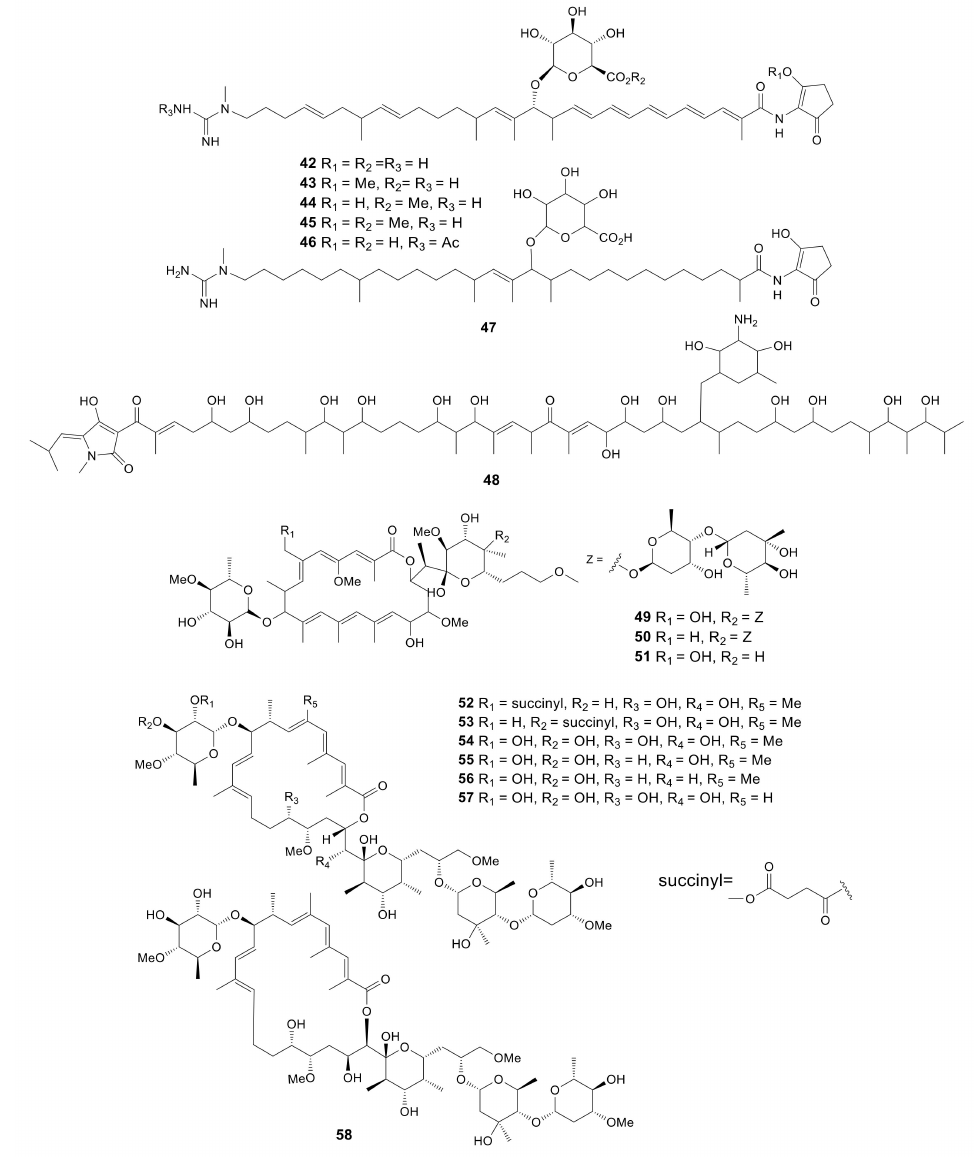
Figure 2. Structures of linear polyketides ( 42 – 48 ) and macrolides ( 49 – 58 ) from Amycolatopsis